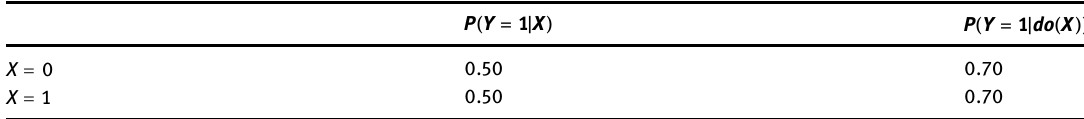
Table 4: MediBot ’ s observed treatment recovery rates vs those reported by the FDA ’ s randomized clinical